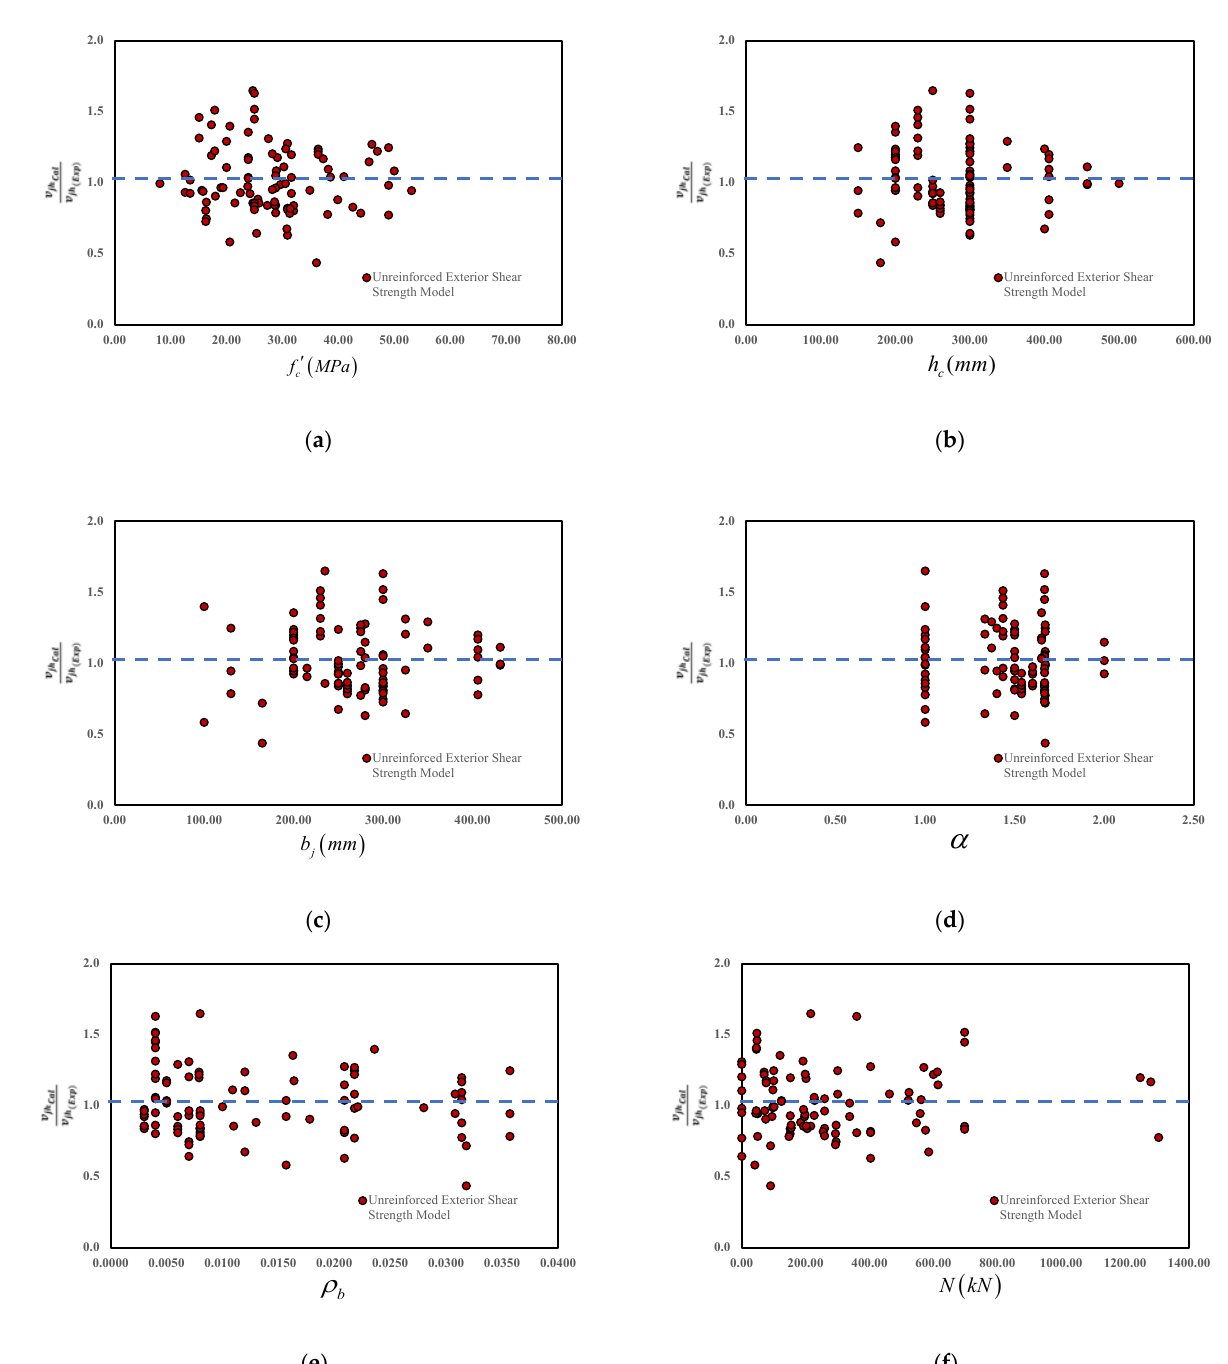
Figure 6. Results for the shear strength of the reinforced interior joints ( a ) training data, ( b ) valida ‐ tion data, ( c ) all data.